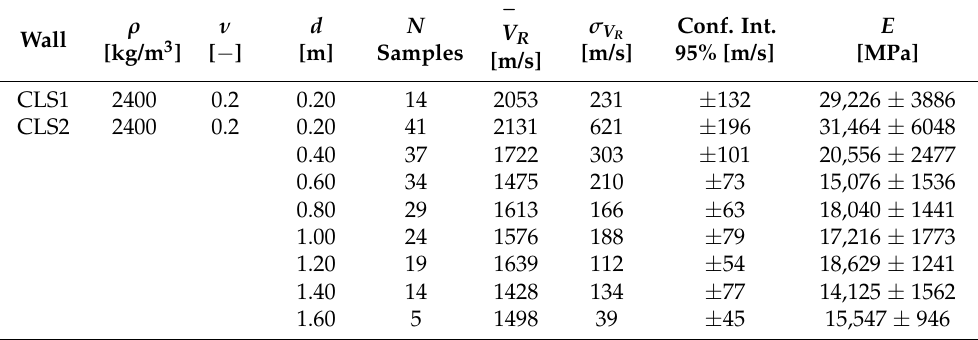
Table 1. Properties of concrete walls CLS1 and CLS2 and impact tests results: mass density ρ ; Poisson ratio ν ; distance between the measurements points d ; number of suitable samples used in the analysis; mean of R-waves velocity V R ; standard deviation of R-waves velocity σ V velocity with a confidence level of 95%; Young modulus E